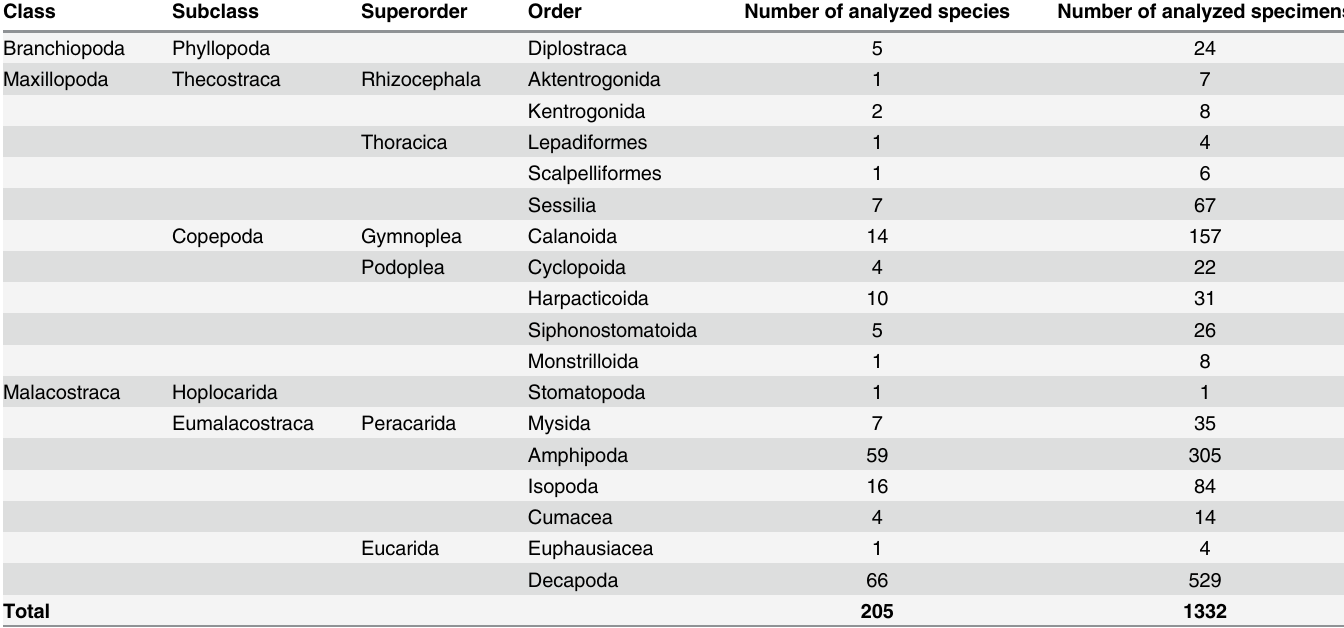
Table 1. Number of barcoded species of different crustacean orders from the North Sea. Note that 136 DNA barcodes of 13 species of the Calanoida (Maxillopoda: Copepoda: Gymnoplea) were already published as part of a previous study [3].